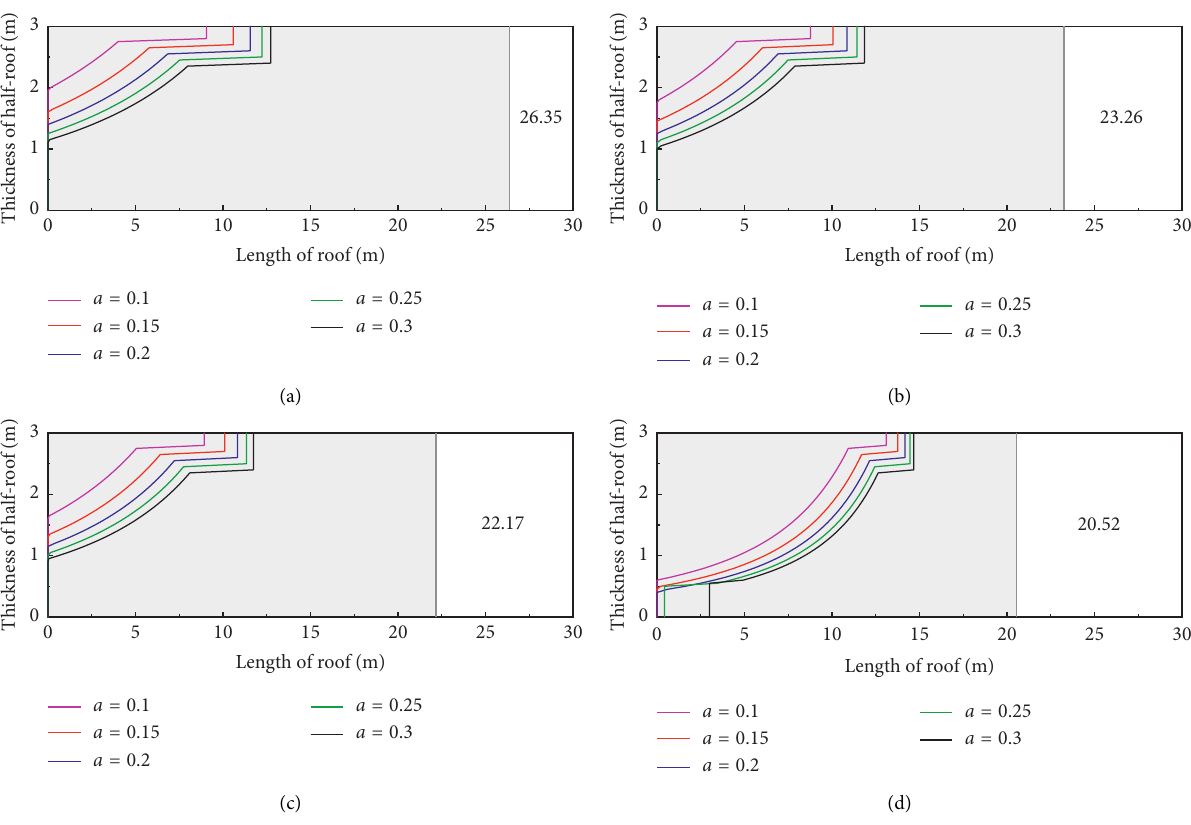
Figure 7: Effect of different crack sizes on the boundary of crack-affected area. (a) Gabbro. (b) Granite. (c) Marble. (d) Oil shale.